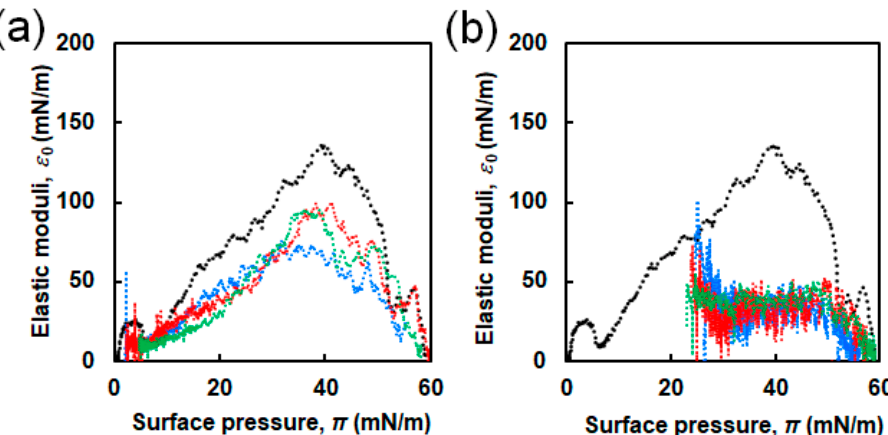
Figure 8. Elastic modulus ( ε 0 ) as function of surface pressure ( π ) for DPPC in the presence of EG n peptides at different concentrations: ( a ) 0.1 μ M and ( b ) 1.0 μ M; n = 6 (blue line), 12 (red line), 24 (green line). Black lines represent ε 0 – π plots for sole DPPC.